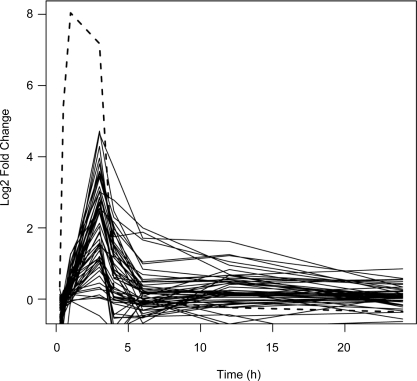
Coordinate increase of numt transcripts after heat treatment.Log2 fold change in gene expression between heat treatment and time-matched controls plotted over a 24 hour time course (3h 38°C) heat treatment followed by 21 hours recovery) for the numt insertion genes (black lines) and the heat shock transcription factor (At2g26150, dashed line). 0h marks the beginning of the heat treatment.